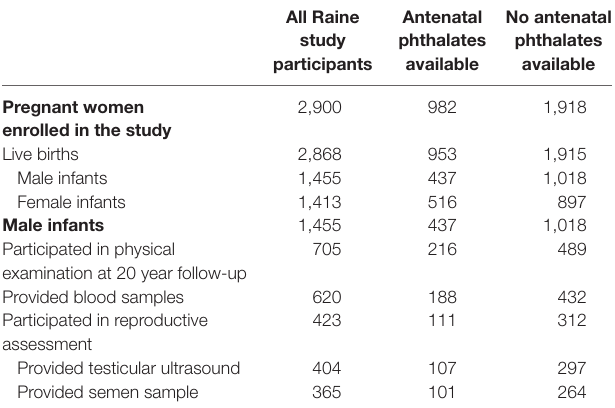
TaBle 2 | Table of flow of participants through the Raine study with respect to availability of maternal antenatal serum for measurement of phthalates, and their involvement in the male reproductive assessment at 20 years of